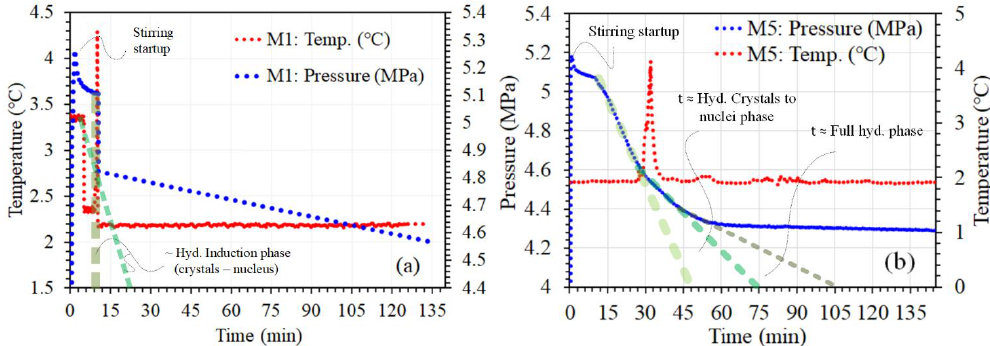
Figure 2. Temperature and pressure profile kinetic measurement of CH₄ gas absorption in pure water ( a ) and in seawater ( b ).